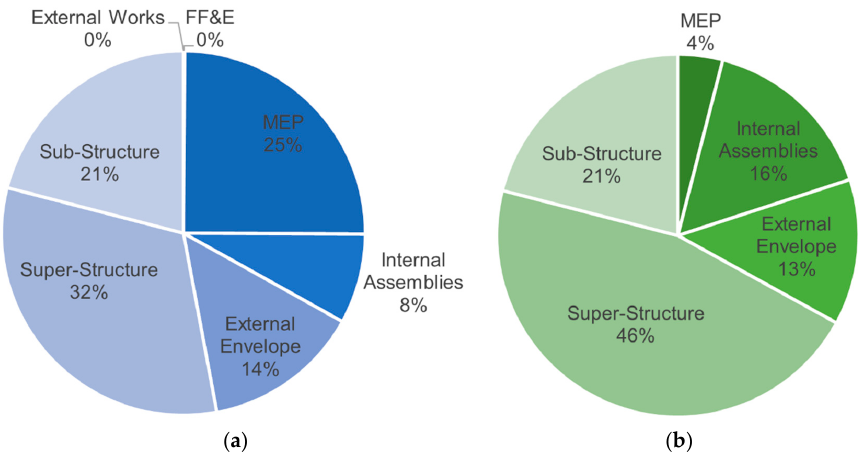
Figure 12. Embodied Carbon shares of building elements (Portlands Place on the left and LETI on the right). ( a ) Portlands Place. ( b ) LETI.